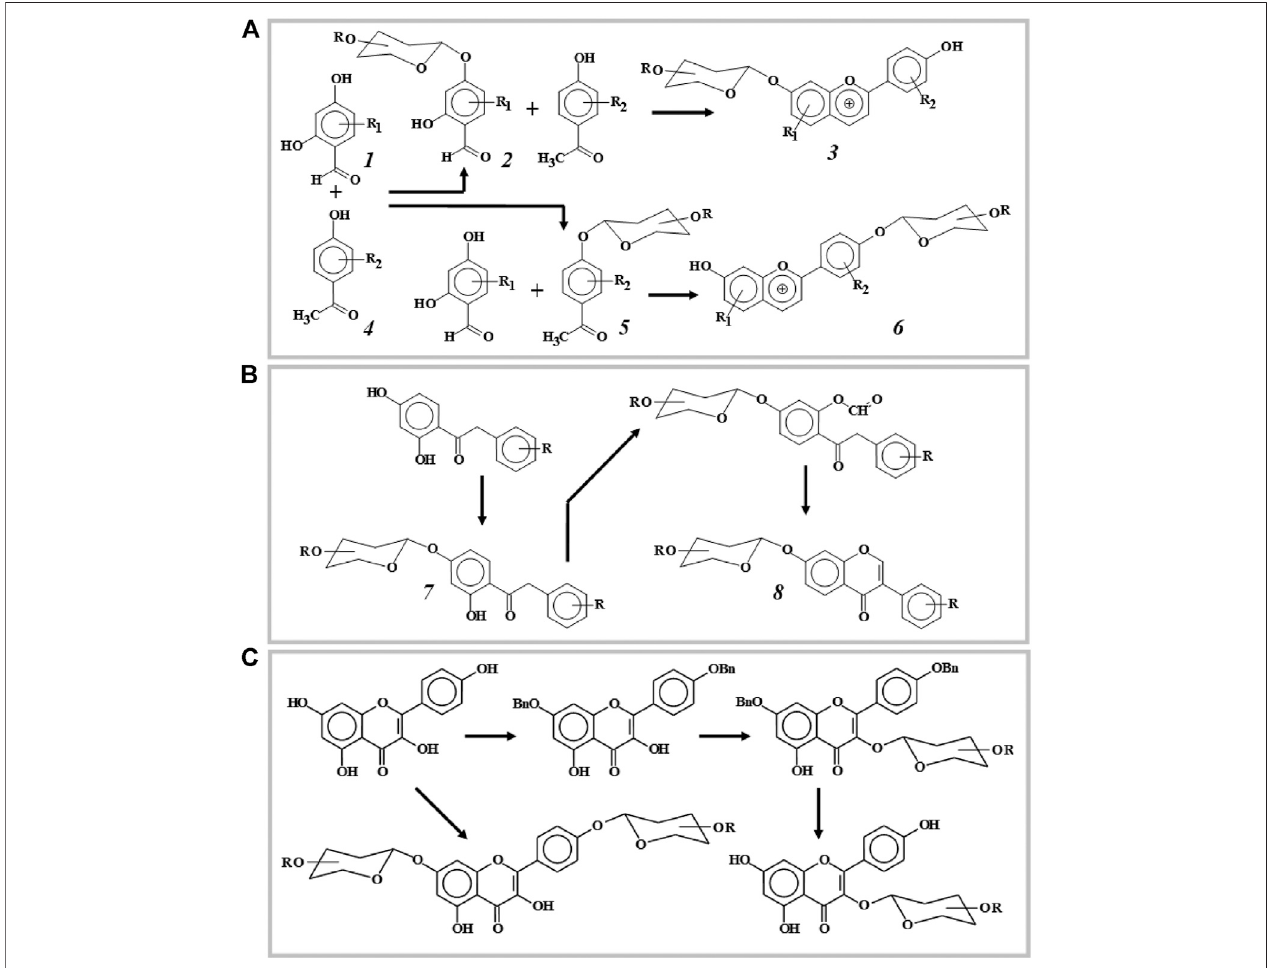
FIGURE 1 | Three strategies of fl avonoid glycosylation. (A) — glycosylation of starting reagents: anthocyanidine synthesis (regioselectivity of fl avonoid synthesis is determined by glycosylation of one of the starting products). (B) — glycosylation of intermediate products: iso fl avone synthesis (the regioselectivity of synthesis is determined by the direction of glycosylation of the intermediate). (C) — glycosylation of synthesis products: obtaining fl avonol glucosides (the direction of glycosylation is regulated by the preliminary protection of certain hydroxyl groups of fl avonol). - β -D-glycosyl fragment with protected hydroxyl